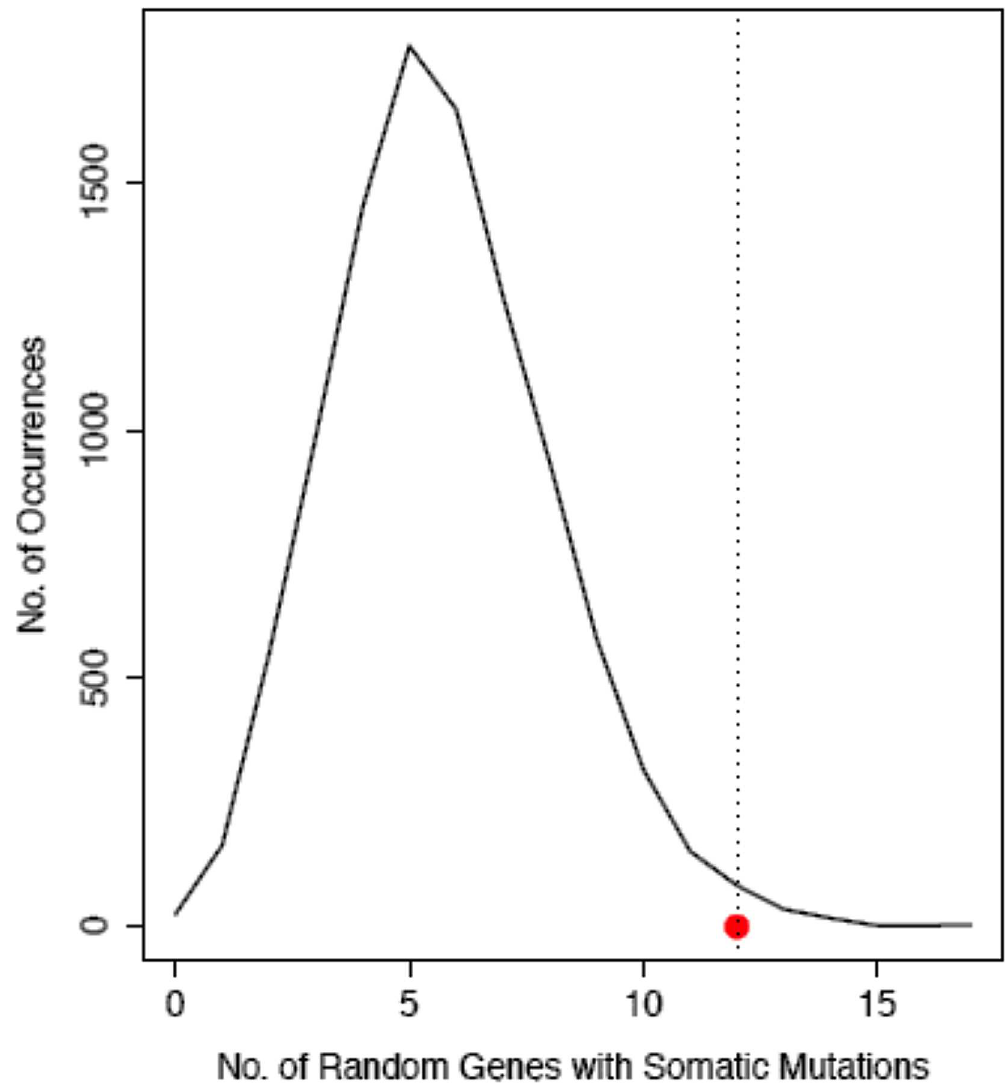
Fig 3. Randomization test for somatic mutations. The curve representsthe distributionof numberof genesthat belongedto the MAPK pathway in the 1000 sets of randomgenes. The mean of the data set is 5.7 somatic mutations in 257 geneswith a standarddeviationof 2.34. The red dot alongthe X--axis depicts a value of 12 –the number of MAPK genes havingsomatic mutations. The P-value was calculatedbased on the number of random sets that had less than 12 genesbelongingto MAPK pathway. The number of somatic mutations observedin MAPK pathway is significantlyhigherthan the mean (P = 0.0046).